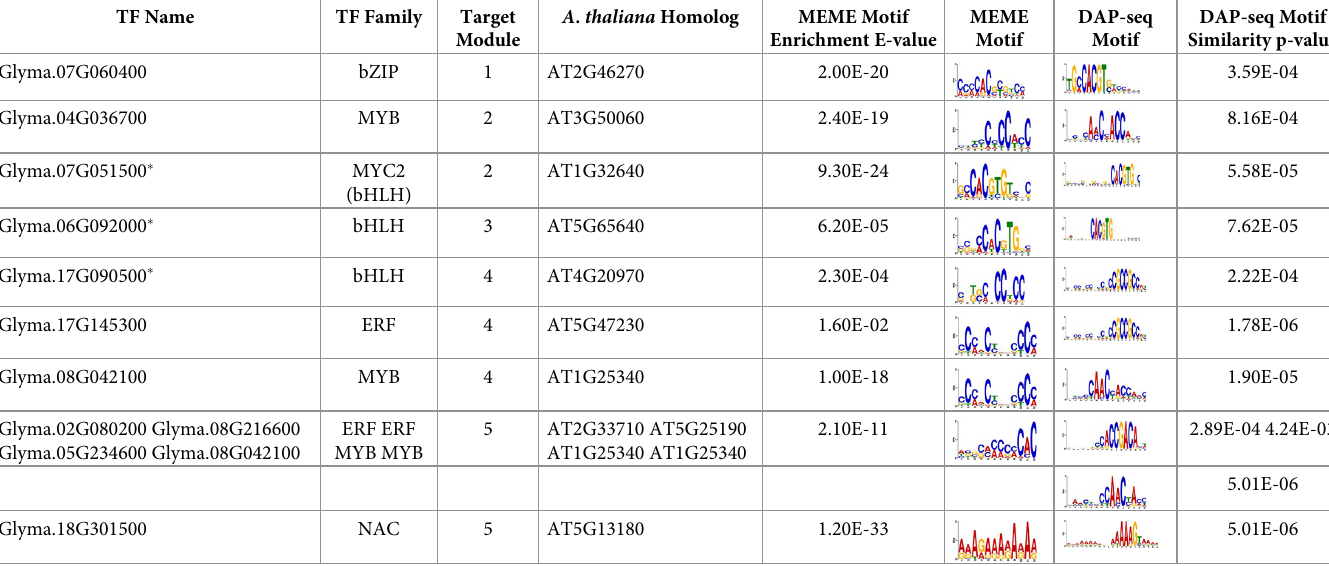
Table 1. A . thaliana and motif validated